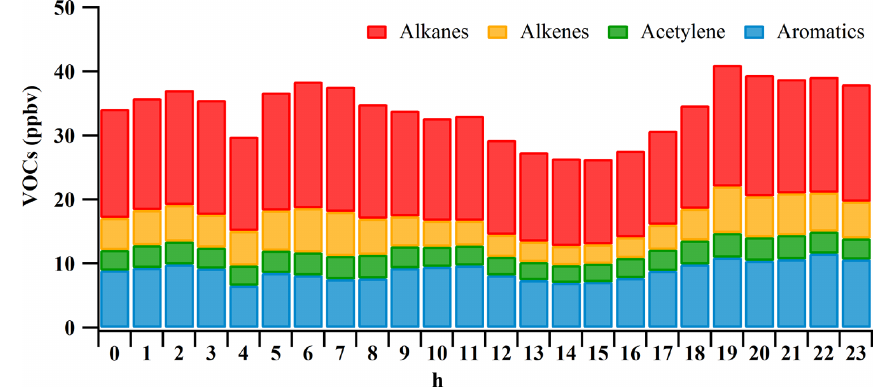
Figure 3. Diurnal variations in volatile organic compounds (VOCs) observed at the Heshan site.